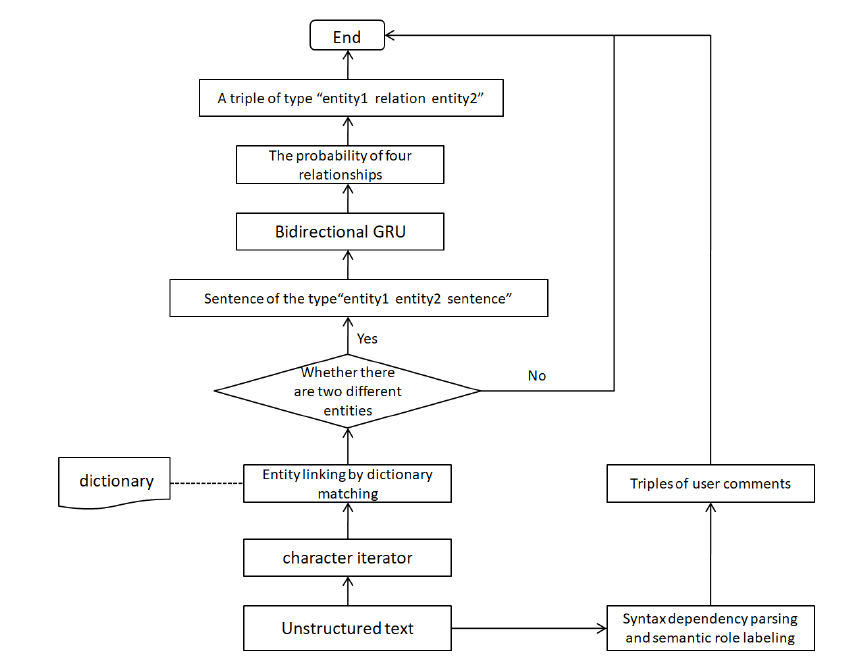
Figure 10. Flow chart of triples